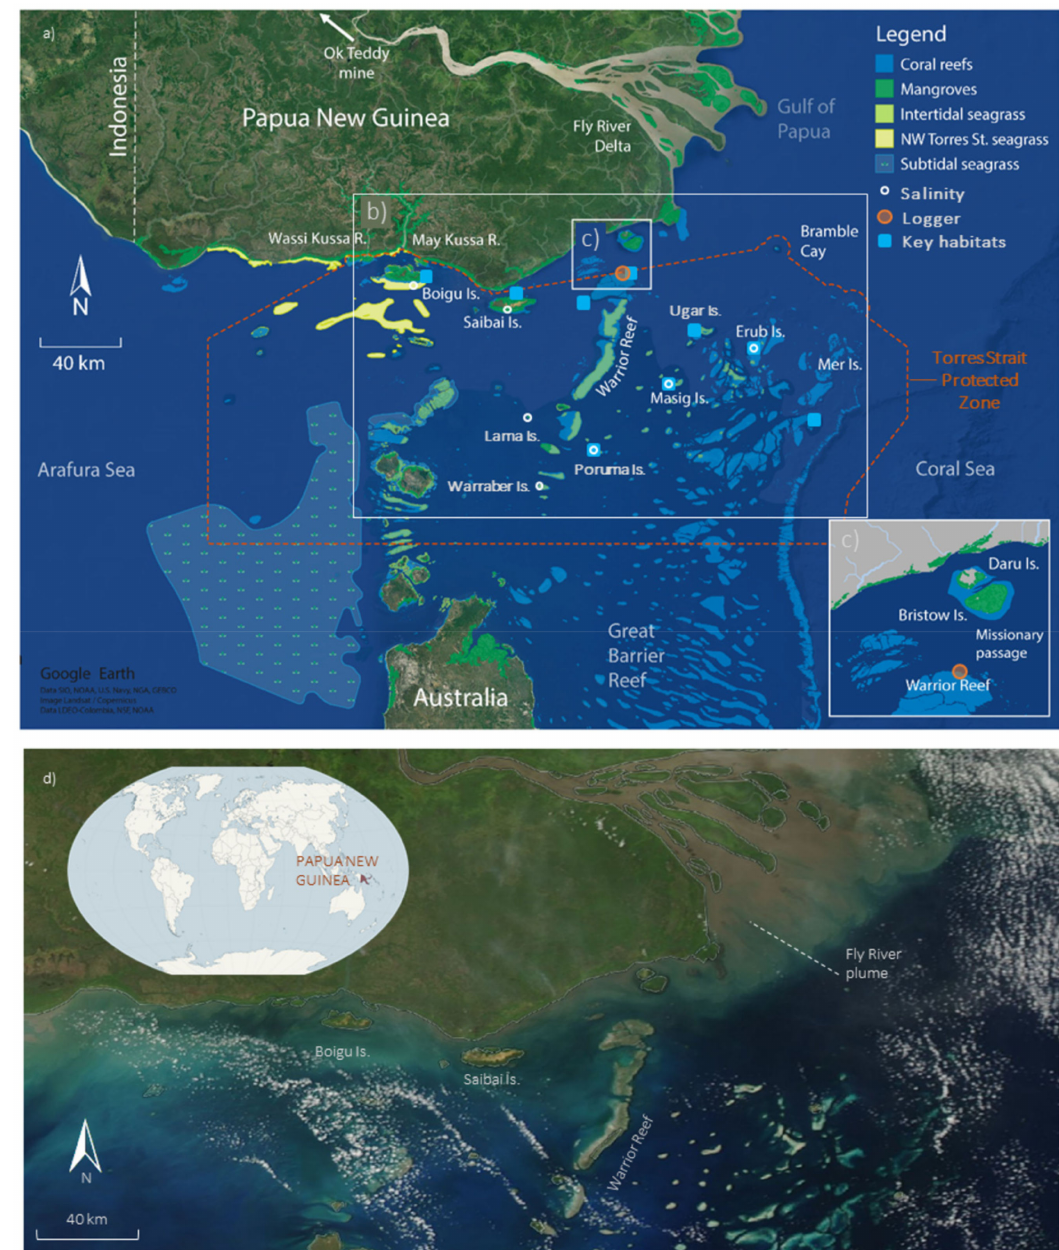
Figure 1. ( a ) Map of the TS region showing the major rivers, islands, the boundary of the TS Protected Zone, and the TS habitats (mapped coral reefs [34], intertidal and subtidal seagrass [35], North-West TS seagrass [36]) ([22], modified). TS habitats assessed in this study are indicated with blue square symbols, collected salinity data with a yellow circle and the location of the loggers with an orange circle. ( b ) Exposure assessment area and ( c ) zoom to Daru Island. ( d ) MODIS-Aqua true colour image of the 12 October 2016 showing the Fly River plume and a general location map. The image is from the NASA Worldview application and shows a large brownish river plume off the Fly River